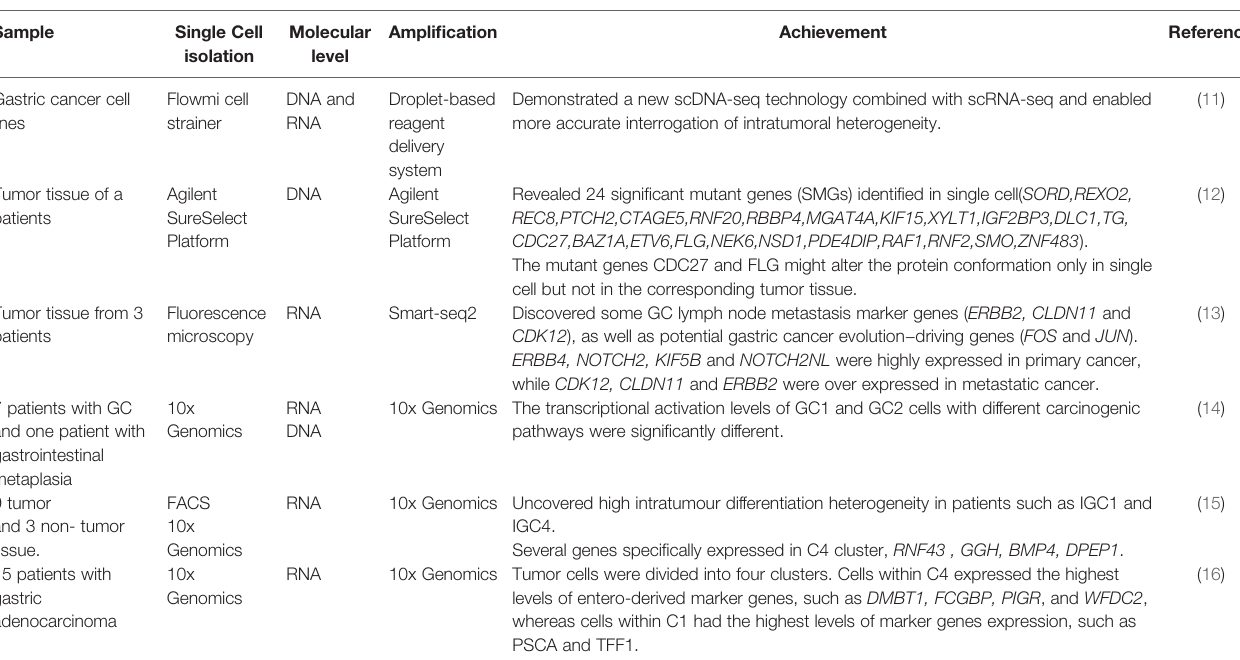
TABLE 1 | SCS in gastric cancer